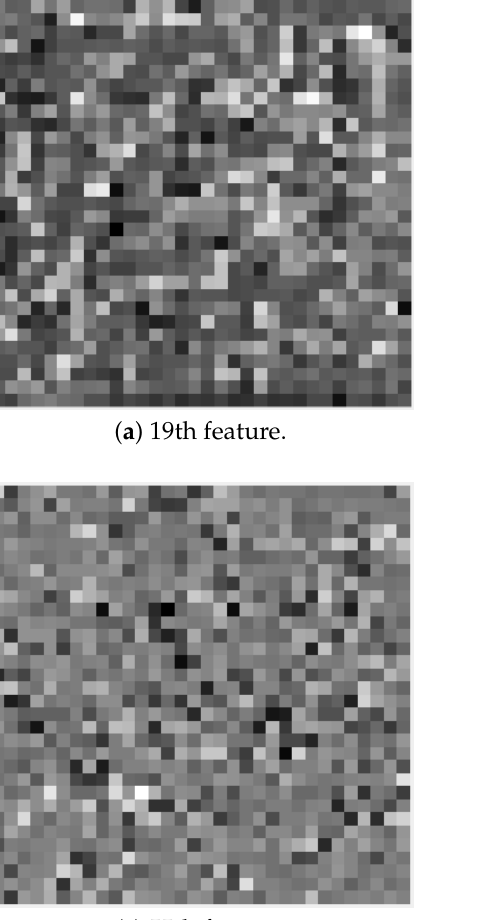
( c ) 55th feature. ( d ) Normalized histogram and Laplacian fitting. Figure 5. Normalized histogram of the i th feature map and Laplacian fitting f ( ., µ , b )